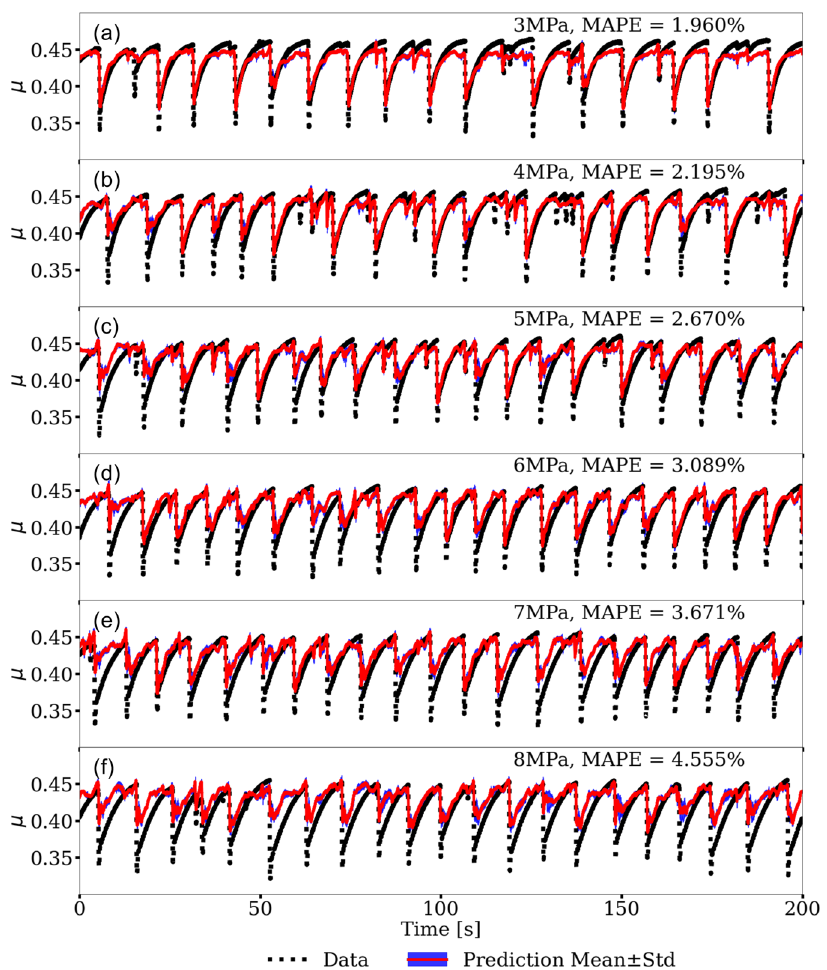
Fig. 7 Transfer learning applied to an independent experiment. Shown are predictions from the cross-trained convolutional encoder-decoder (CED) model (experiment p4581) with normal loads that progressively increase from 3 to 8 MPa (see Fig. 6, (a-f), respectively). Each load level is predicted independently using the cross-trained model from simulation (the encoder and decoder) and data from experiment (p4677) conducted at 2.5 MPa. The predictions as manifest by the mean absolute percentage error (MAPE) progressively decrease with increasing load level. Nevertheless, the results show that the transfer learning approach with cross-training of the latent space, which accounts for only 20% of the total CED model parameters, is a powerful approach to predicting the frictional state of the experimental